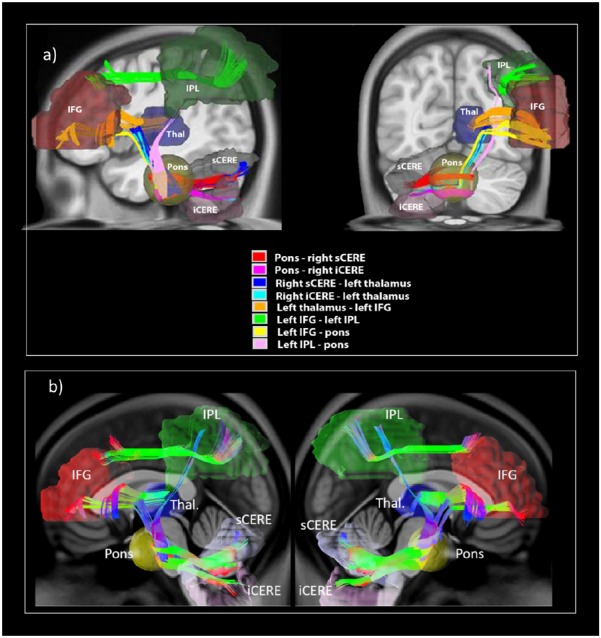
White matter tracts reconstructed in the current study illustrating (a) reconstructed white matter tracts; (b) shows reconstructed left cerebro-right cerebellar tracts (on the left) and reconstructed right cerebro-left cerebellar tracts (on the right).